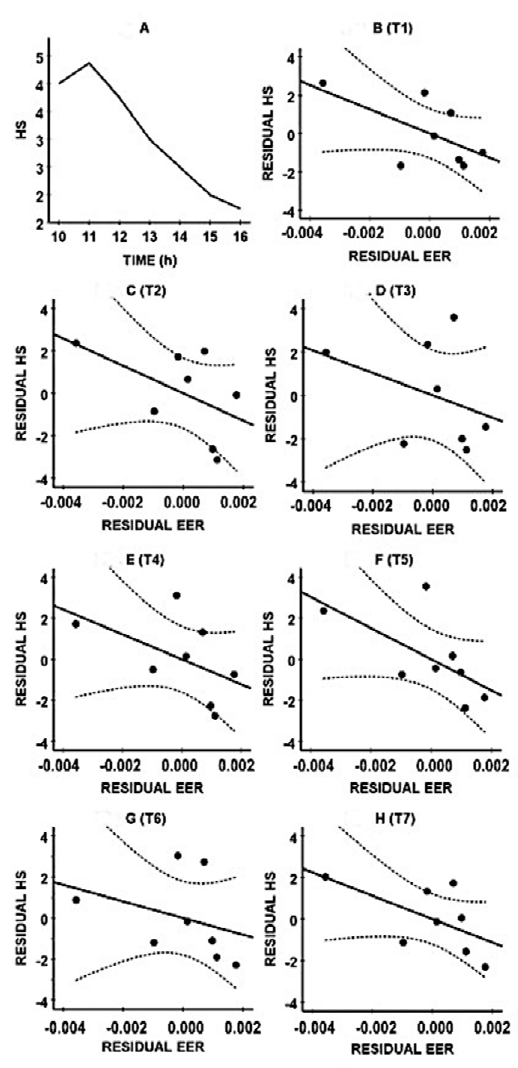
Figure 2. Relationship between ethanol elimination rate and hangover severity. ( A ): mean (SE) hangover severity; ( B ): T1 (10.00); ( C ): T2 (11.00); ( D ): T3 (12.00); ( E ): T4 (13.00); ( F ): T5 (14.00); ( G ): T6 (15.00); ( H ): T7 (16.00).